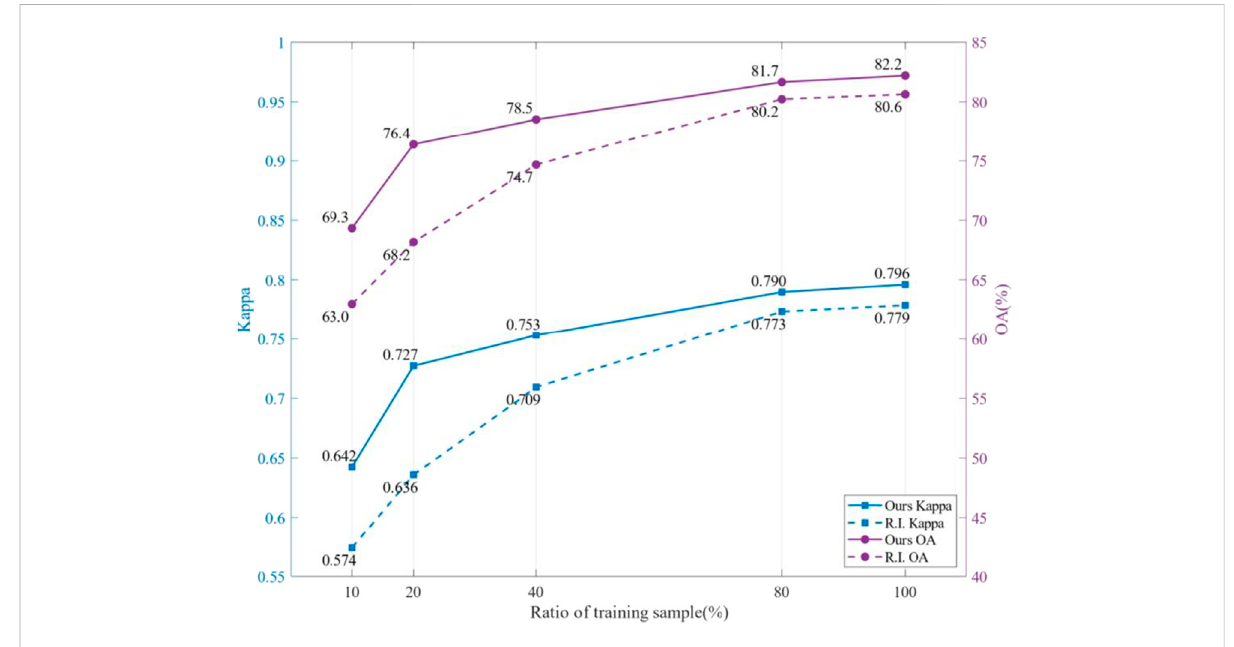
FIGURE 6 Results obtained using different ratio of training samples. R.I., random initialization.